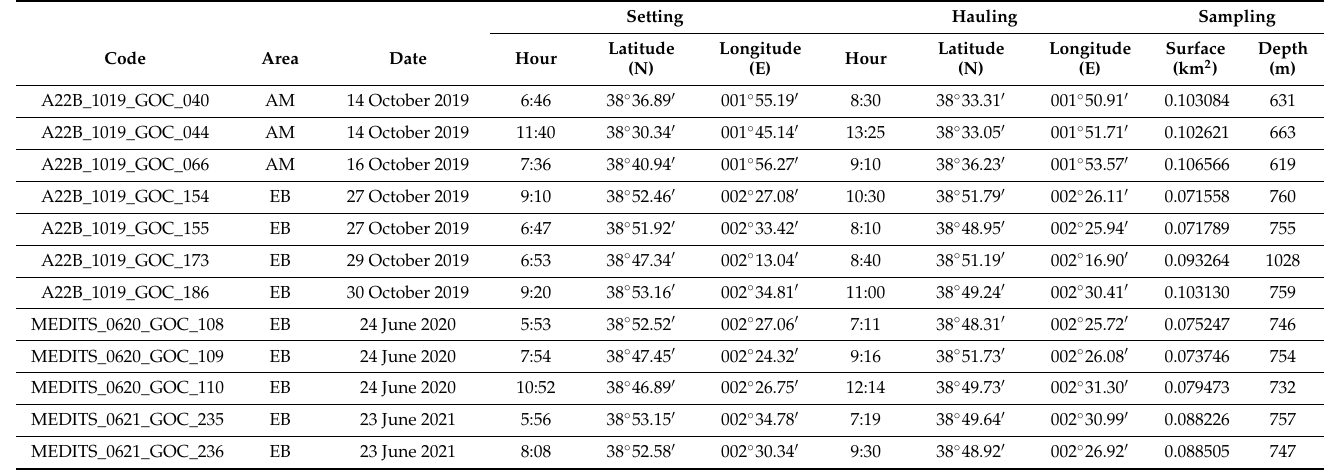
Table A4. Characteristics of the sampling stations carried out with the experimental bottom trawl GOC-73 in the fishing grounds adjacent to the Mallorca Channel seamounts Ausias March (AM) and Emile Baudot (EB) during the INTEMARES